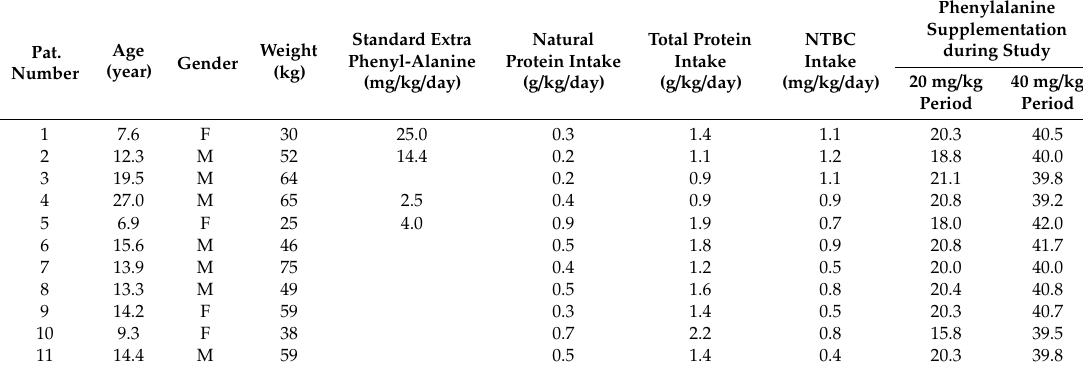
Table 2. Patient